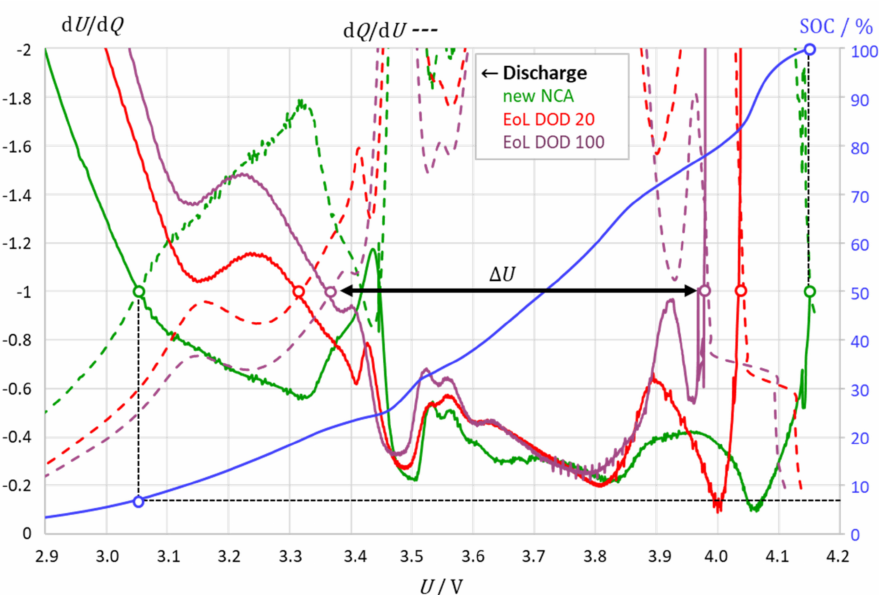
Figure 5. NCA batteries of the same type (SONY): First derivative of the constant current discharge characteristics for new samples and end-of-life parts after constant current cycling test (900 cycles, 0.3 A). The usable voltage range and SOC window between the intersection points ( ◦ ) becomes smaller with forced aging. For comparison: SOC curve (blue) of the new battery. Table 2 adds an LCO battery; the discharge profiles (not shown here) were not qualita- tively different from the examples